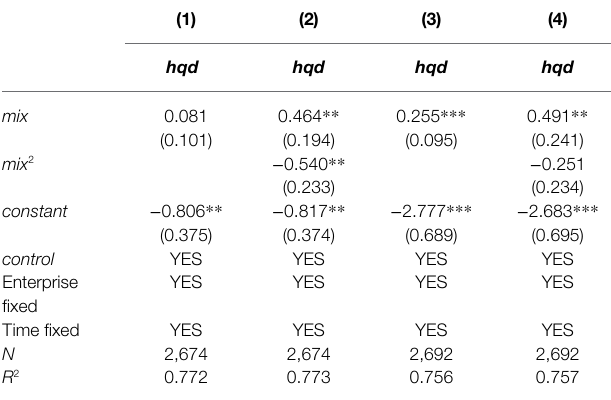
TABLE 7 | The analysis of the temporal